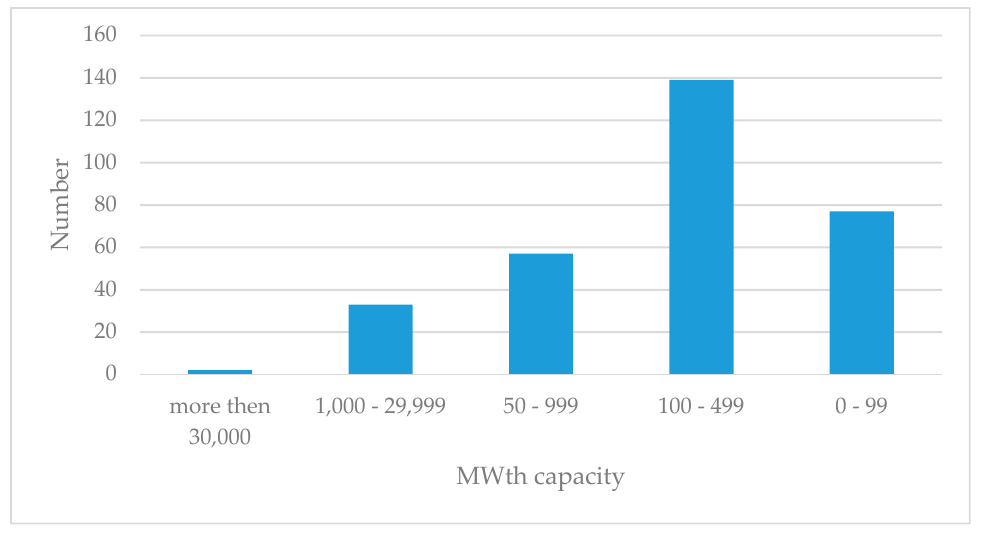
Figure 6. Distribution of industrial solar installations (capacity, gross area) by application [23]. Currently, the leaders in the cumulative area and capacity of installed industrial solar collectors are Oman, China, Chile, USA, Mexico, and India (Figure 7). Other countries are significantly inferior to them in the development of the SHIP market. With the exception of the United States, the leading countries in terms of the development of solar collectors in the industry are rapidly developing industrial countries in which the industrial sector mainly generates the growth in demand for thermal energy. For example, the growth of thermal energy consumption in the industrial sector of India in the period from 2010 to 2015 increased by more than 30% [24,25].